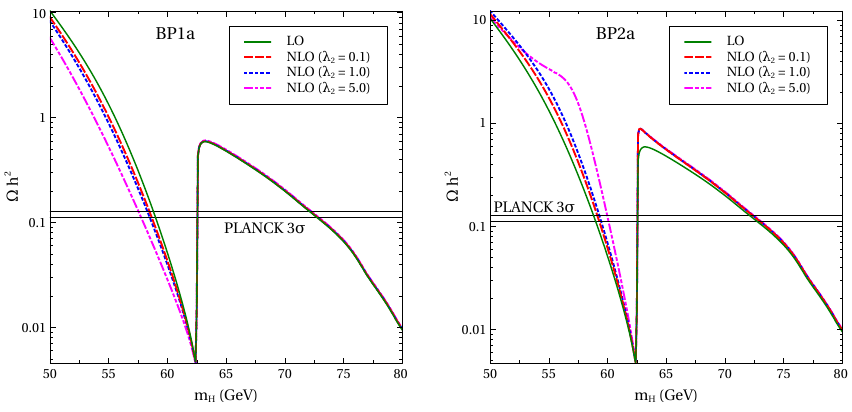
Figure 2 . Variation of the thermal relic with the DM mass (50 GeV < m H < 80 GeV). The tree level and one-loop values are denoted by the green solid and red dashed ( (cid:21) 2 = 0 : 1), blue dotted ( (cid:21) 2 = 1) and pink dot-dashed ( (cid:21) = 5)